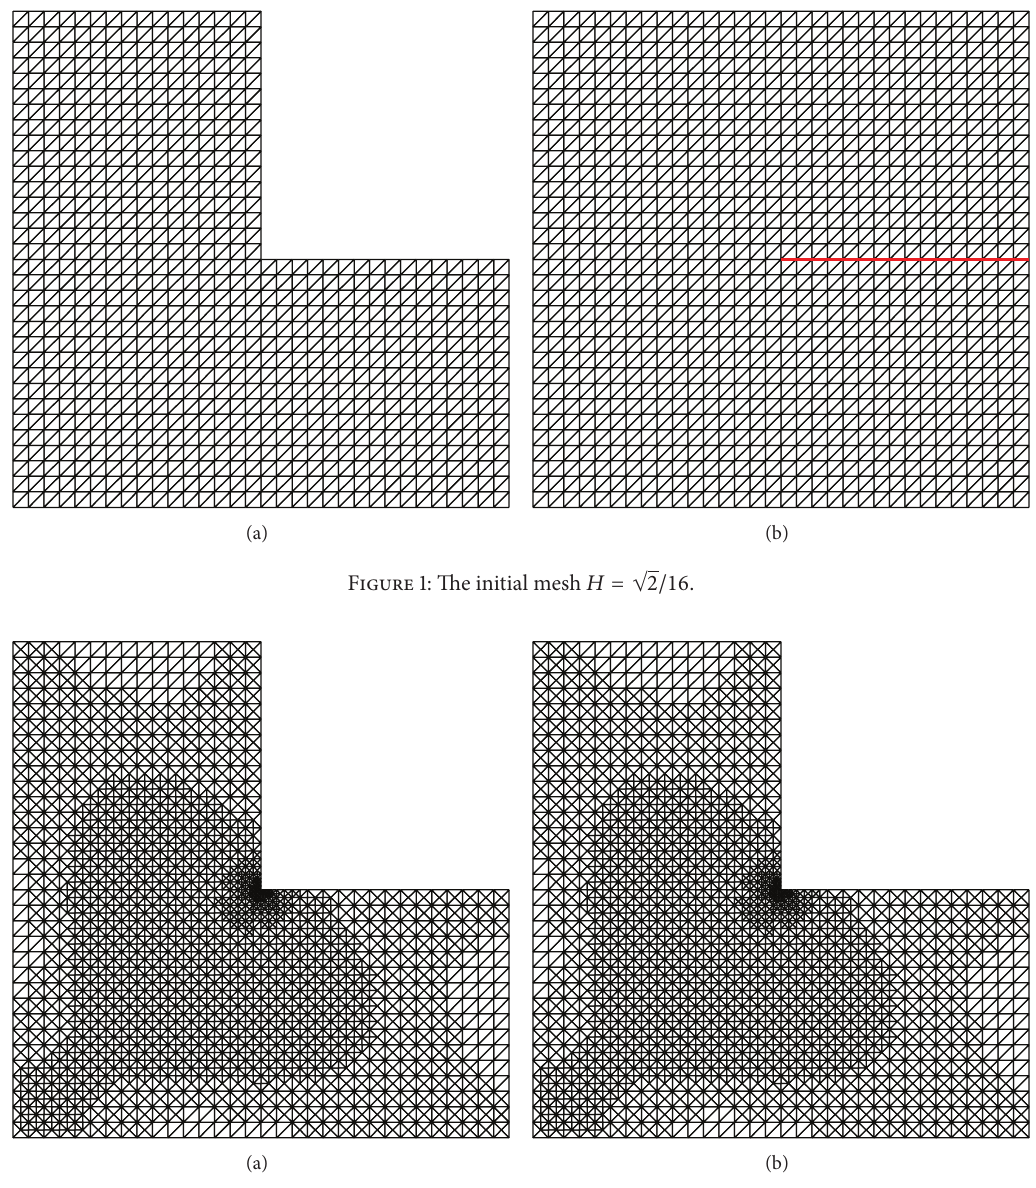
Figure 2: The adaptive meshes of 1st eigenvalue after 5th iteration by Algorithm 10 (a) and Algorithm 11